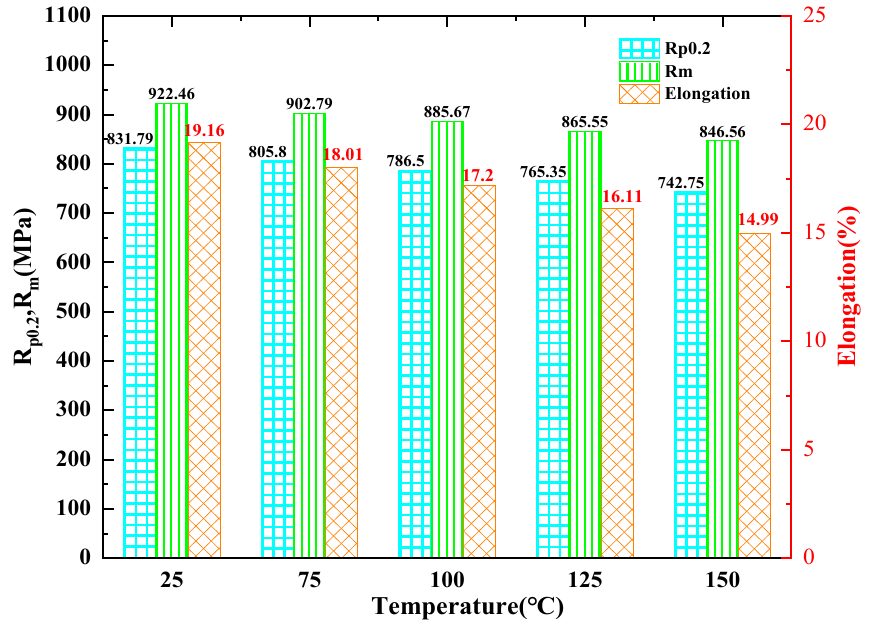
Figure 5. Tensile results of the 13Cr110 including yield strength (Rp0.2), ultimate strength (Rm), and elongation at break ( δ ).